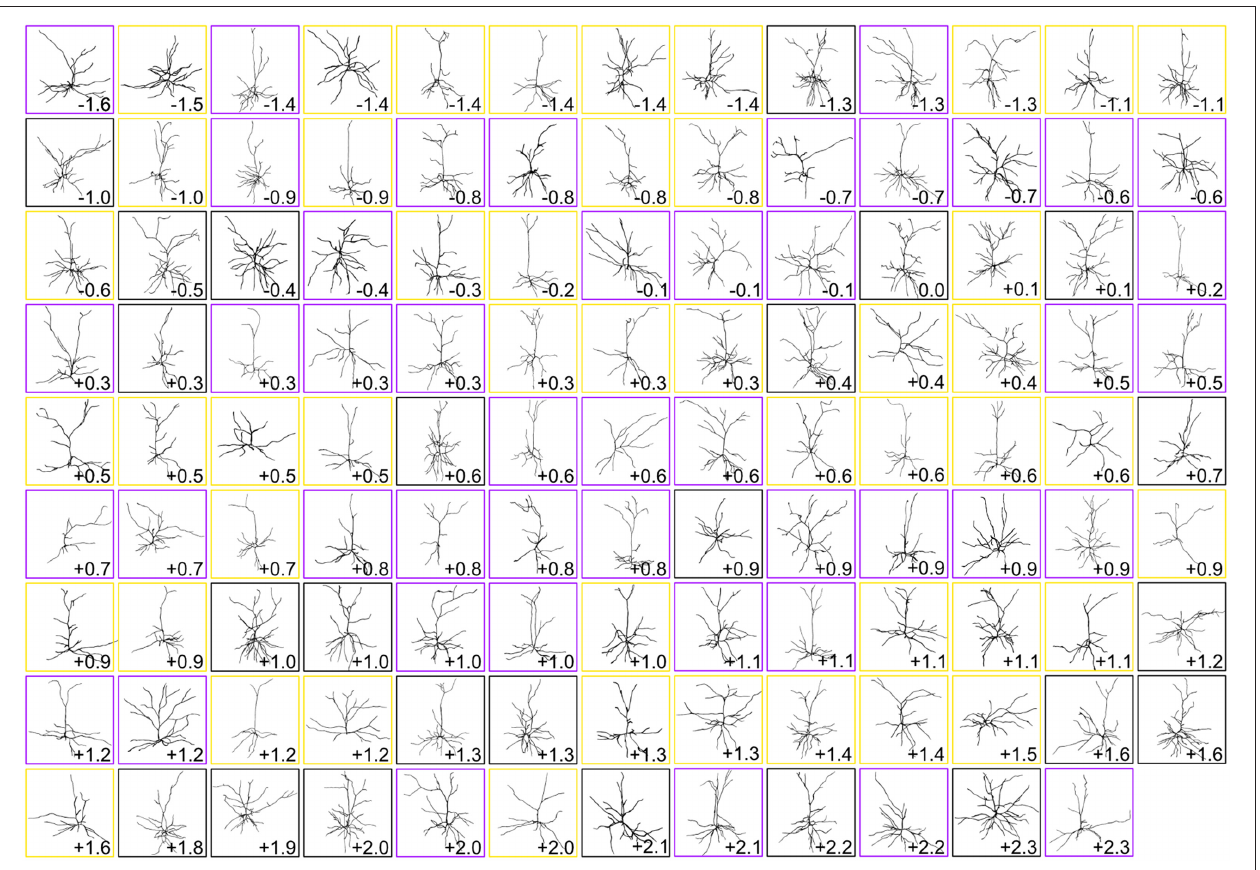
FIGURE 2 | Gallery of dendritic reconstructions. All 116 pyramidal neuronal reconstructions analyzed in this study displayed with apical dendrites pointing upward. For clarity, reconstructions have been resized to fit each box and are not to scale. Neurons are arranged from most caudal (top left) to most rostral (bottom right). Neurons in boxes of the same color (black, purple, or gold) were taken from the same brain. Numbers indicate rostrocaudal distance of each neuron’s section to the splenium of the corpus callosum (negative numbers are caudal to splenium, and positive numbers are rostral to